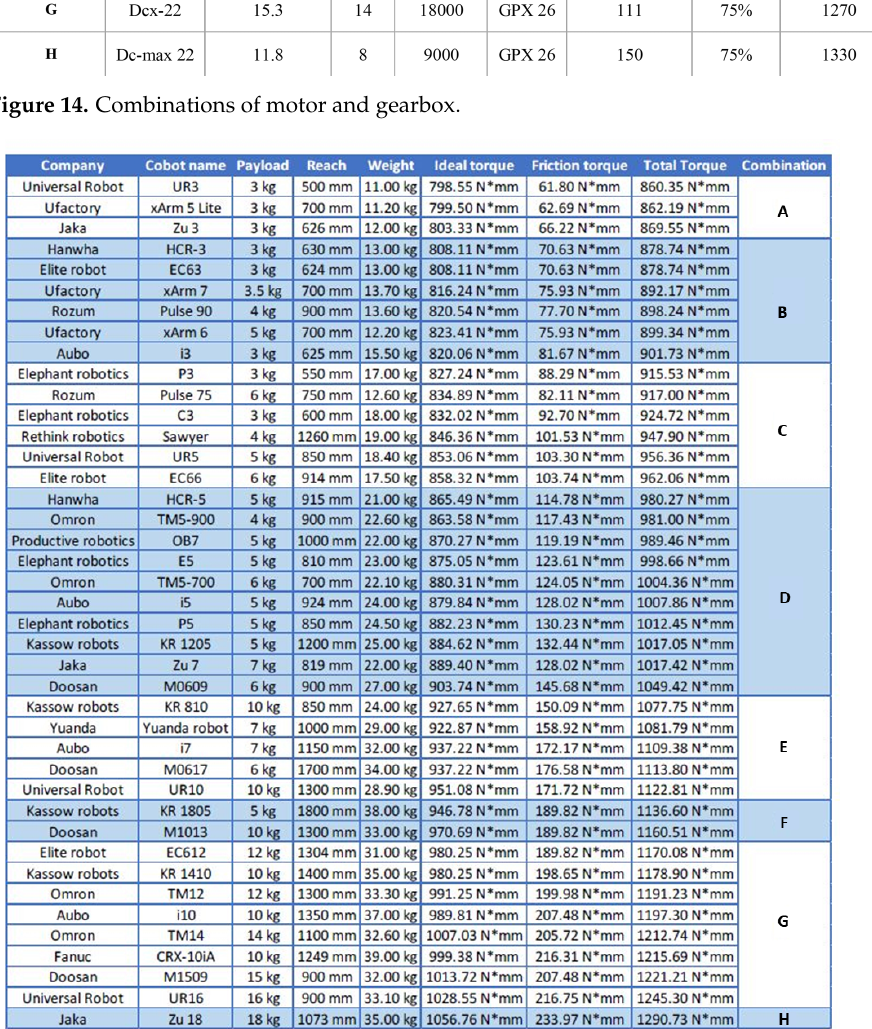
Figure 15. Total torque includes the bearing frictional torque. Eight possible combination (DC motor-gearbox) have been identified to meet the required torque for over 40 cobot